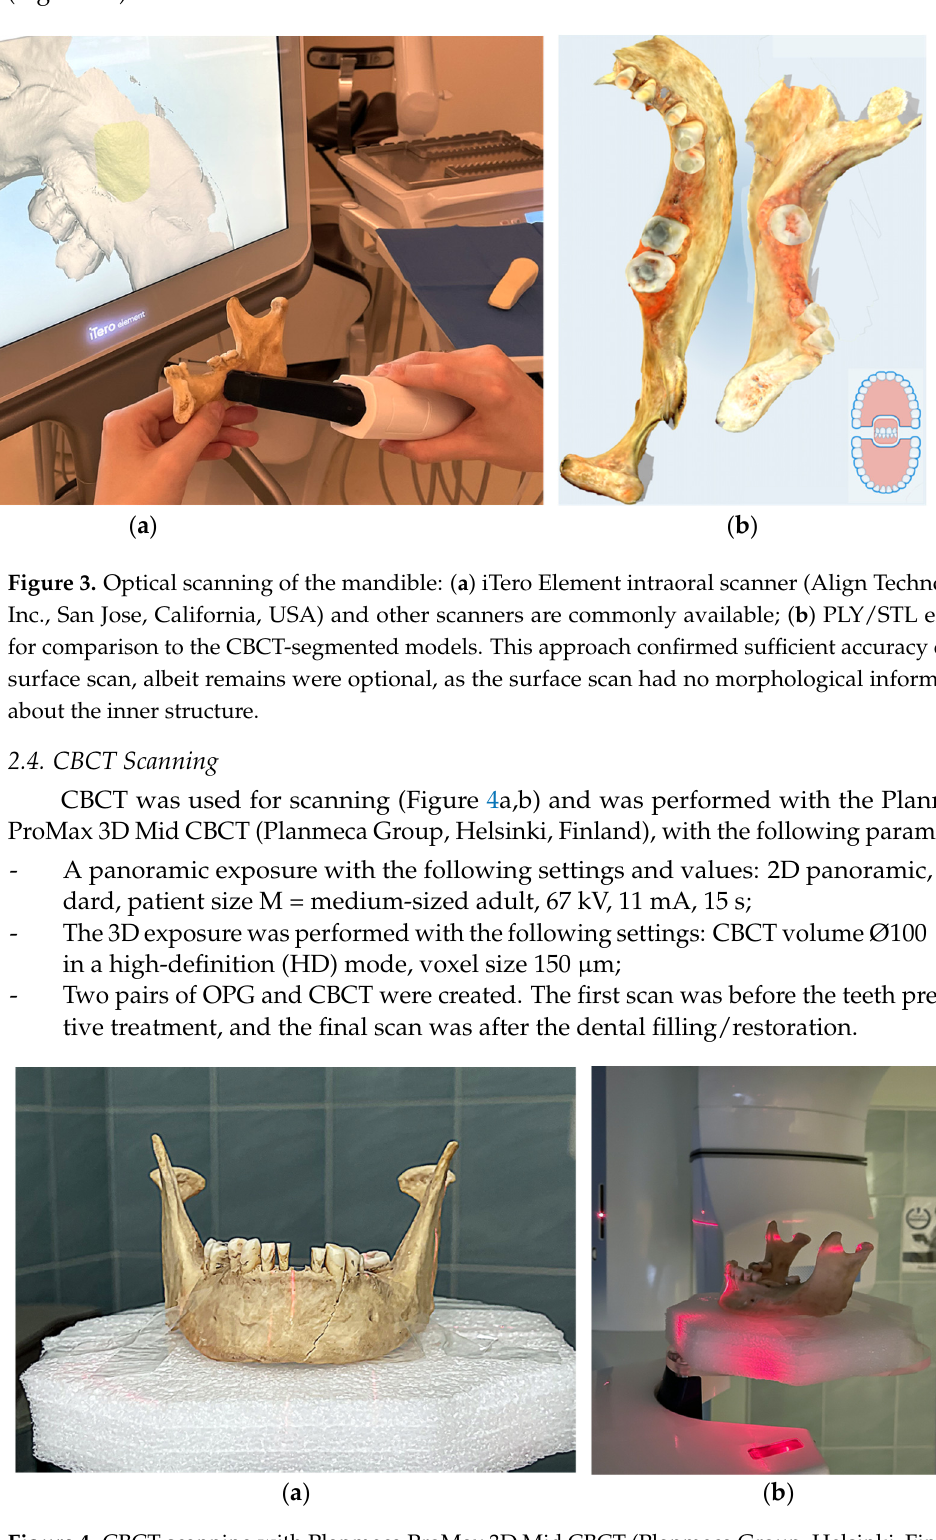
Figure 4. CBCT scanning with Planmeca ProMax 3D Mid CBCT (Planmeca Group, Helsinki,